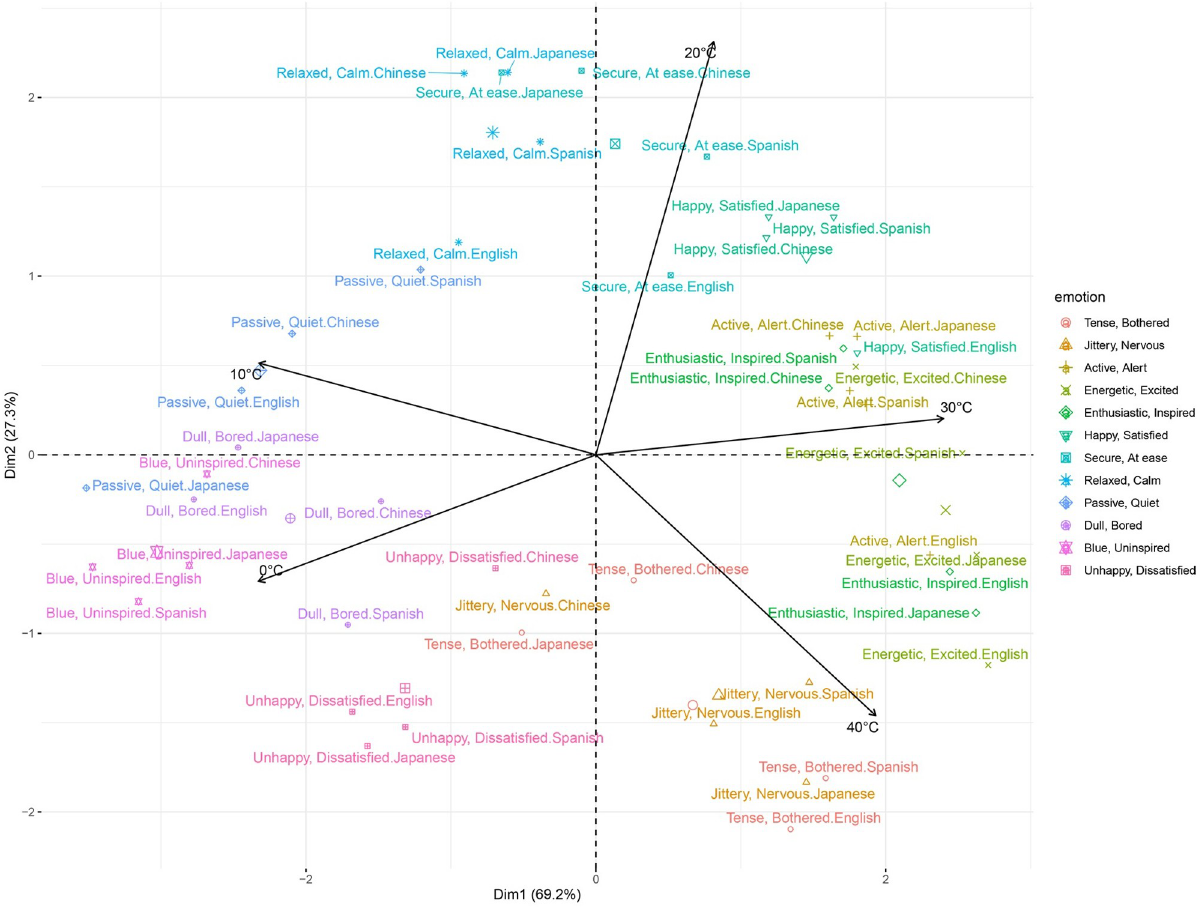
Fig 3. Principal Component Analysis (PCA) biplot in Experiment 1. The variables visualized are the temperature-emotion association ratings for the different temperatures. The individual observations of emotions per each language (in different colors and shapes) are superimposed. The emotion categories are color-coded following the canonical circumplex model of affect, starting with Tense/Bothered in the third quadrant. Dimension 1 seems to describe arousal, and Dimension 2 seems to describe valence. Associations in the PCA move clockwise with increasing temperature starting from 0˚C in the third quadrant, which translates into a counterclockwise movement in the canonical circumplex model of affect.